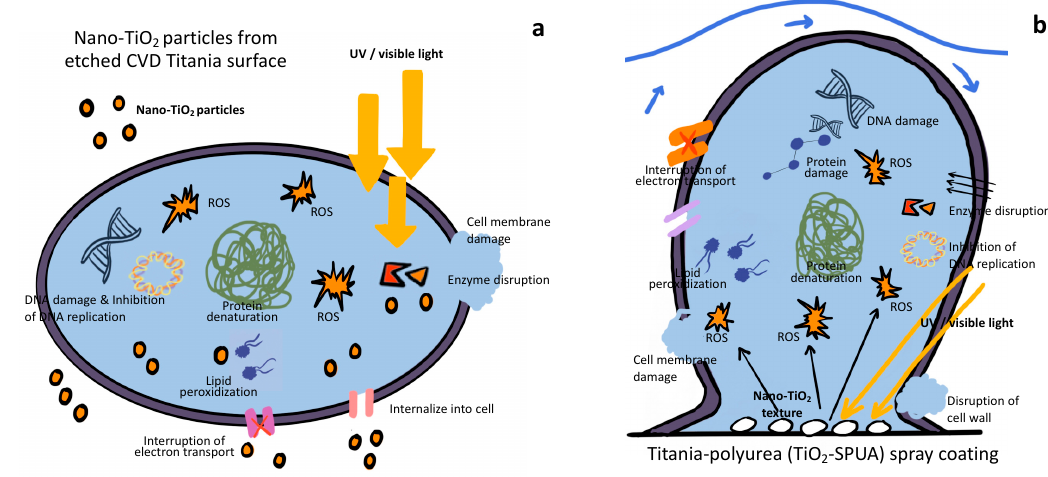
Figure 5. Schematic diagram of different anti-biofouling processing caused by nano-TiO 2 photodegradation ( a ) nano-TiO 2 particles from etched CVD TiO 2 surface, and ( b ) Titania–polyurea (TiO 2 –SPUA) spray coating.